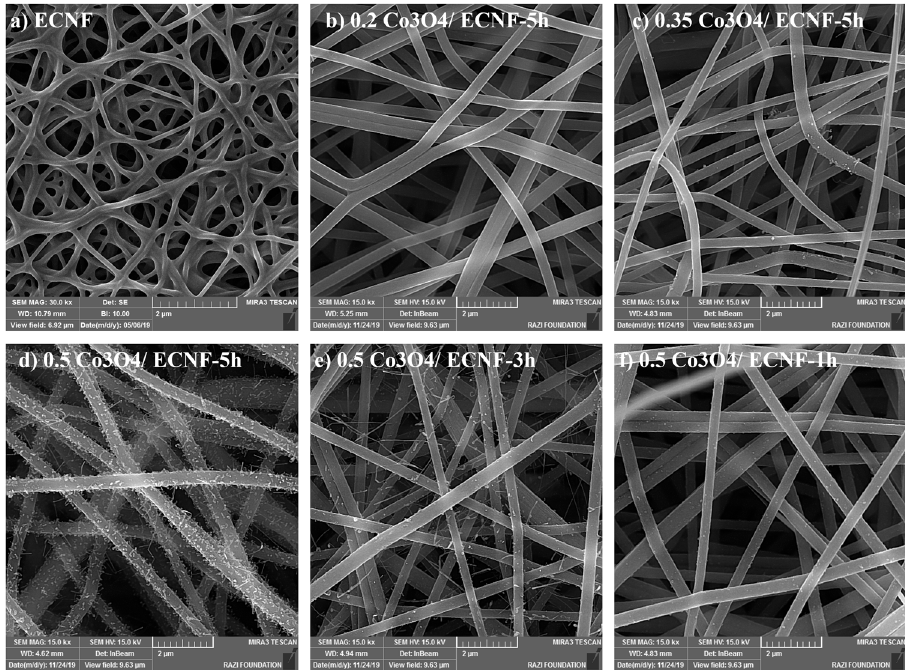
Figure 1: FESEM images of ( a ) ECNF, ( b – d ) Co 3 O 4 /ECNF nanocomposites with di ff erent amounts of CoAC salt, and ( e and f ) Co 3 O 4 /ECNF nanocomposites with di ff erent carbonization